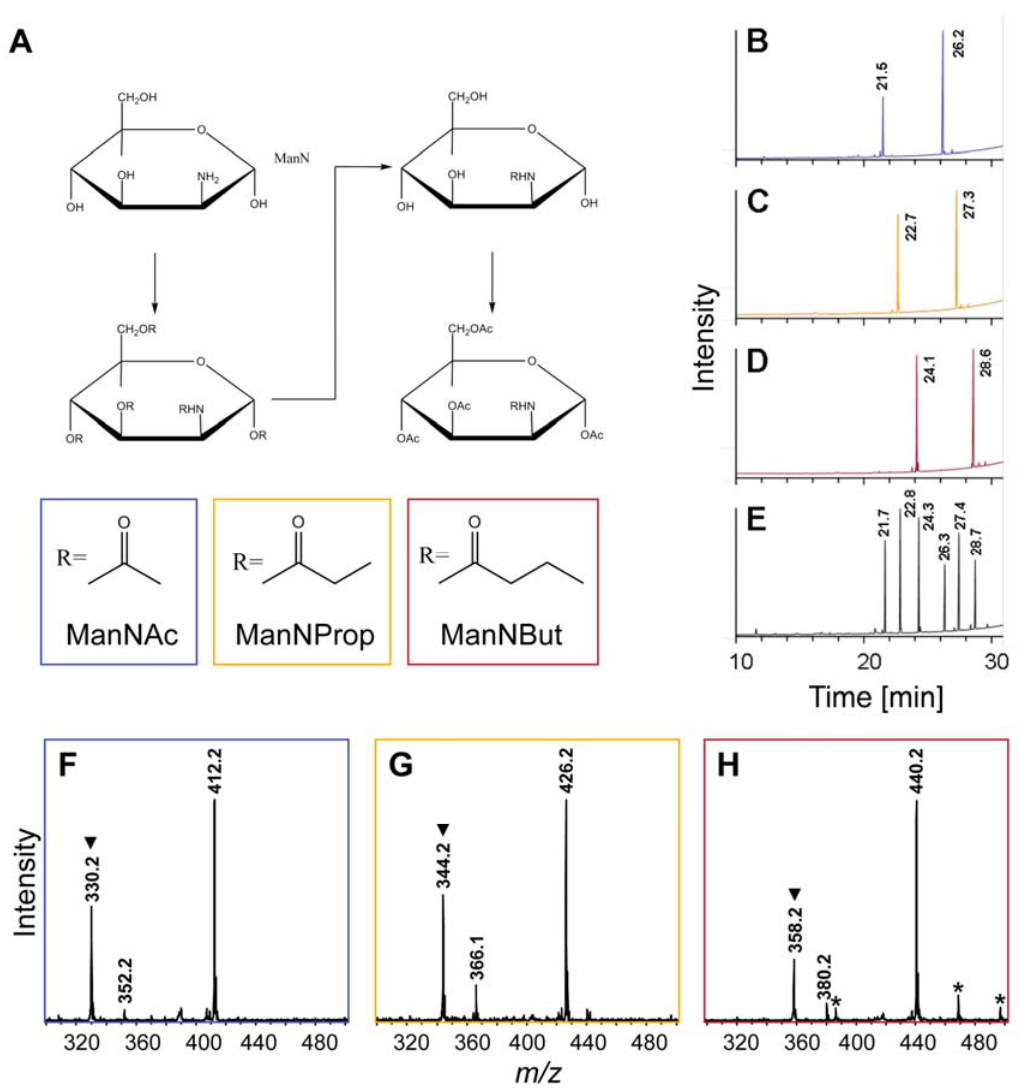
Figure 2. Chemical synthesis of peracetylated N -acyl-ManN derivatives. ( A ) Reaction sequence including peracylation, cleavage of O -acyl-residues and peracetylation. GC analyses were performed to confirm the synthesized structures to be peracetylated ( B ) ManNAc, ( C ) ManNProp, and ( D ) ManNBut by comparing respective retention times to those of ( E ) standard substances, which were confirmed by NMR analysis. Further structural verification was performed by ESI-MS analyses of peracetylated ( F ) ManNAc, ( G ) ManNProp, and ( H ) ManNBut registered as sodium adducts ([M+Na] + ) as well as sodium adducts after the loss of acetic acid. Hydrogen adducts ([M+H] + ) formed after the loss of acetic acid are marked by trianglels ( ▼ ) and unidentified signals are labeled by asterisks (*). Retention times as well as monoisotopic masses are assigned with the first decimal